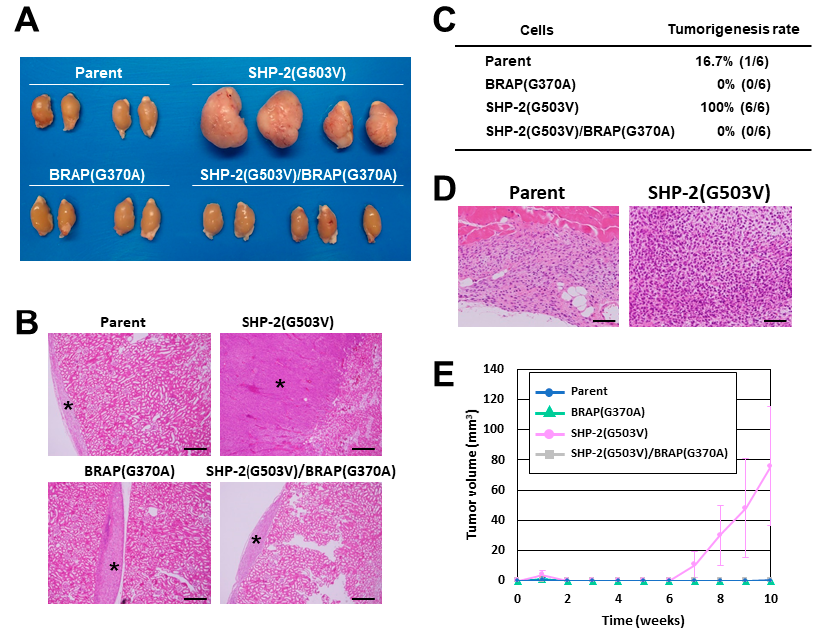
Figure 3. Tumor formation by sNF96.2 cells harboring missense mutations of BRAP and PTPN11 . ( A ) Macroscopic appearance of the kidneys of Balb/c nu/nu mice at 3 months after renal subcapsular injection of sNF96.2-GFP (Parent) or SHP-2 (G503V)-, BRAP (G370A)-, or SHP-2 (G503V)/BRAP (G370A)-expressing sNF96.2 cells (1 × 10 6 ). ( B ) Representative hematoxylin–eosin staining of tumors in ( A ). Asterisks indicate tumor tissue. Scale bars, 500 µm. ( C ) Tumorigenic rate for the indicated cells (5 × 10 6 ) at 70 days after subcutaneous injection in Balb/c nu/nu mice. ( D ) Representative hematoxylin–eosin staining of tumors in C . Scale bars, 100 µm. ( E ) Time course of tumor volume for tumors in C . Data are means ± SD ( n = 6).